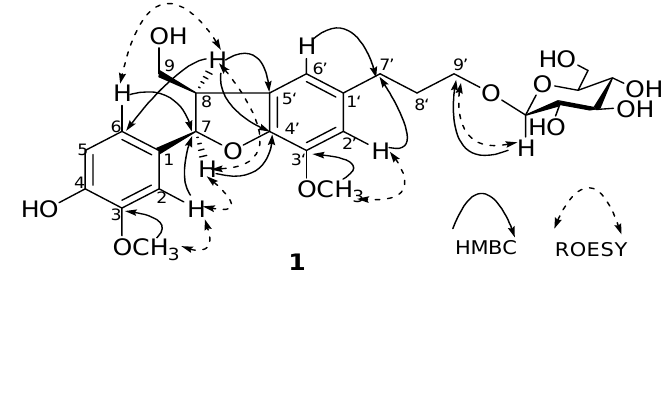
Table 1. The 1 H- and 13 C-NMR Data of 1 (in CD